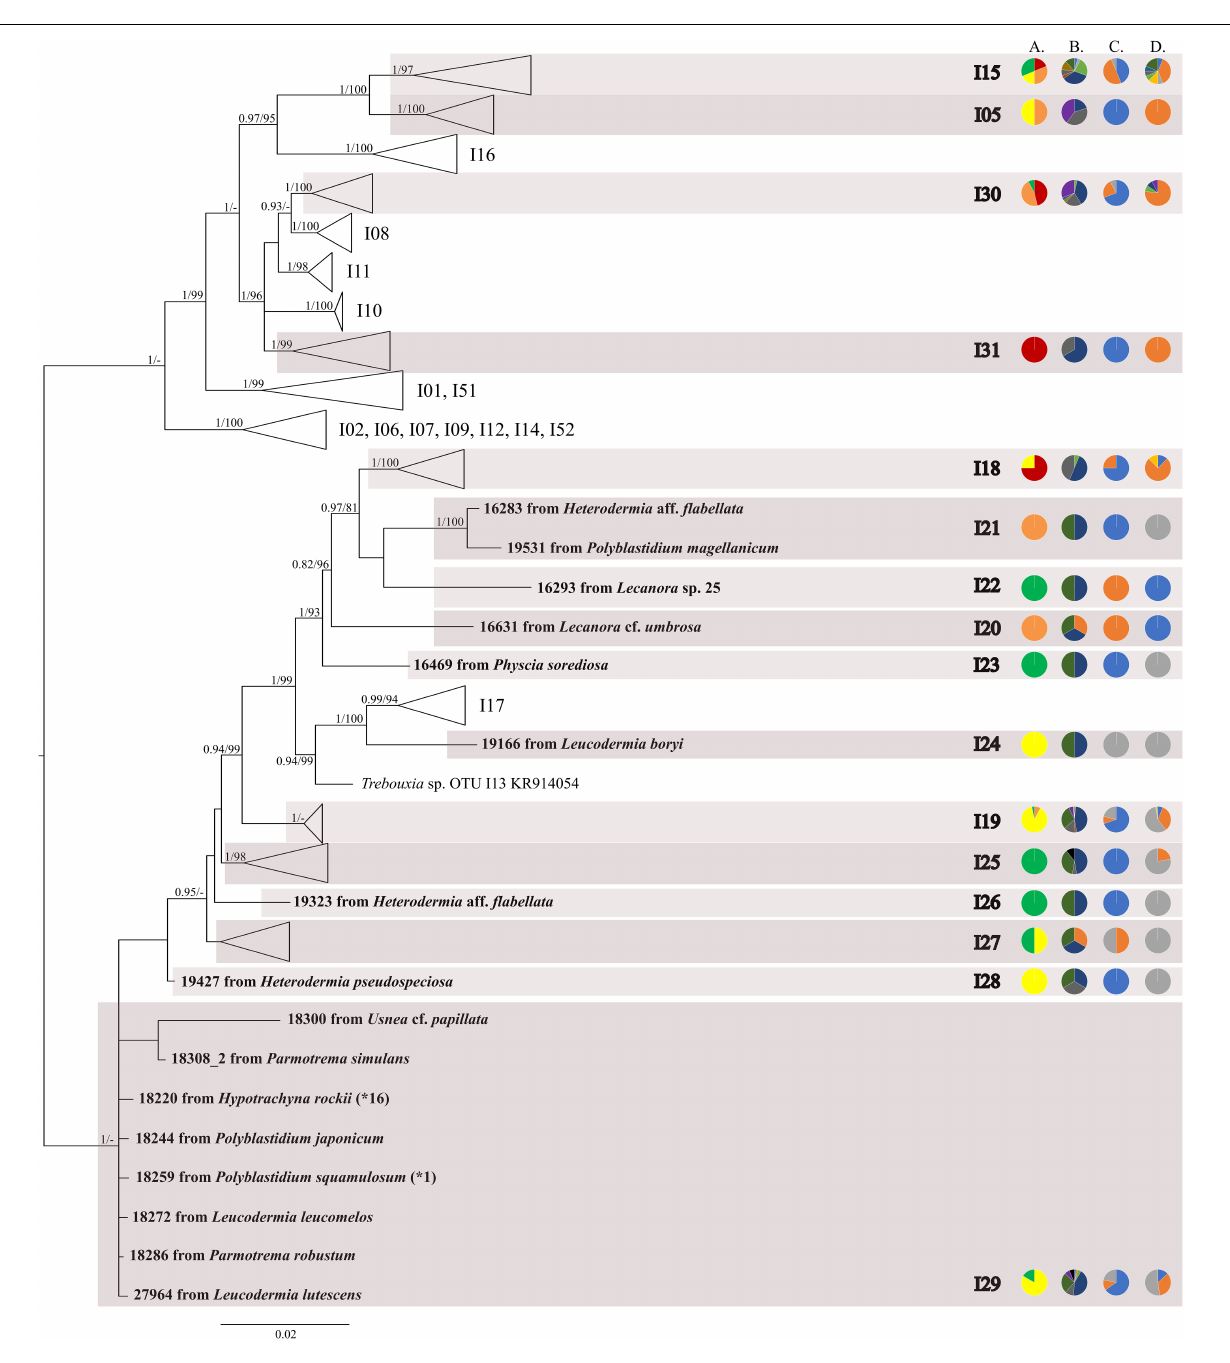
Frontiers in Microbiology |